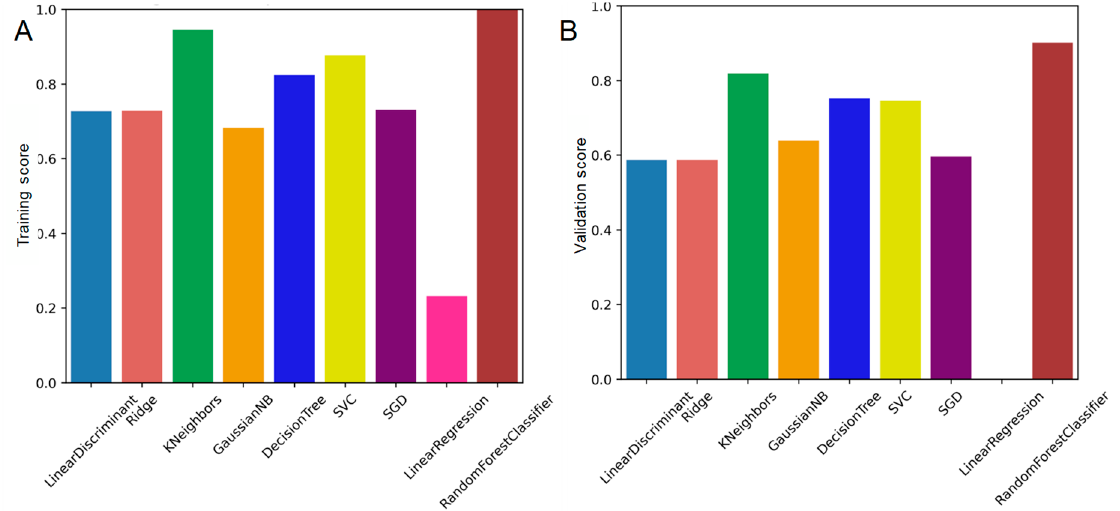
Figure 3. ML model performance for all tumor locations. Training score ( A ) and validation score ( B ).